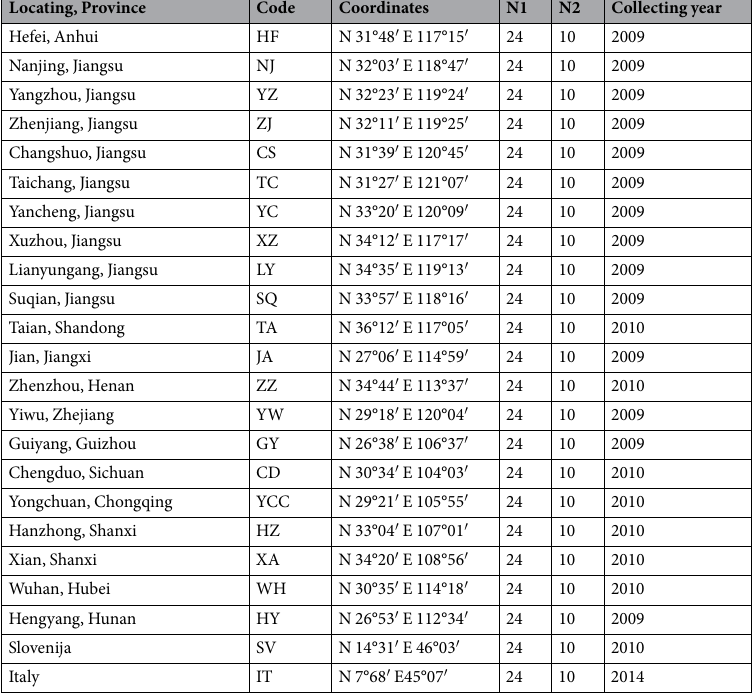
(5 ′ -TAAACTTCAGGGTGACCAAAAAATCA) 44 , ND1-F (5 ′ -ATTCAGACTCTCCTTCAGCA) and ND1-R (5 ′ -GGATAACAGCCTAATCTTCT), and ND5-F (5 ′ -AAAATCACCTCAACTATCAT) and ND5-R (5 ′ -GCTCCTACACCAGTTTCTTC). Primers for ND1 and ND5 were designed based on the complete mito- chondrial genome sequence of C. ciliata 45 . Conditions for PCR amplification were as follows: initial denatura- tion for 5 min at 95 °C, followed by 35 cycles at 94 °C (1 min each), annealing for 1 min at 45–50 °C, elongation for 1–3 min (depending on predicted fragment length) at 68 °C, and a final extension step at 72 °C for 10 min. Amplification products were purified and then sequenced by Invitrogen Biotechnology Co. (Shanghai, China). Amplification of microsatellites and determination of fragment size. The nine microsatellite loci, primer sequences, and PCR conditions used in the current study were previously described by Yang et al. 46 . Amplifications were conducted using DNA from 24 individuals per population (total number = 552). Amplified PCR products were analyzed by Sangon Biotechnology Co. (Shanghai, China) using the ABI 3730 automated DNA sequencer (Applied Biosystems). GENEMAPPER v. 3.5 (Applied Biosystems) was used to obtain allele designations. Fragments comprising the three mitochondrial genes were initially aligned using ClustalX v. 2.0 47 . The number of variable sites and haplotypes, haplotype diversity, and nucleotide diversity of the three mtDNA genes ( COI , ND1 and ND5 ) were calculated by DnaSP v. 5.0 48 . The expected and observed heterozygosity, polymorphic information content, and estimated null frequency were calculated for each locus in individual populations using CERVUS v. 3.0.3 49 . The number of alleles (A), allelic richness (AR), inbreeding index (Fis), and observed and expected heterozy- gosity (Ho and H E ) were calculated by FSTAT v. 2.9.3.2 50 . The deviation from Hardy-Weinberg equilibrium for each population and linkage disequilibrium for pairs of loci was calculated with GENEPOP v. 3.4 51 , and P values were adjusted using the Sequential Bonferroni procedure 52 . Null alleles were identified using Micro-Checker v. 2.2.3 53 . T-tests were used to evaluate the significance of differences in diversity estimates haplotype diversity (H), nucleotide diversity ( π ) and number of alleles (A) of the populations using JMP v.12. Population groups were identified using concatenated sequences of the three mtDNA genes; information on longitude and latitude were included, and the data were analyzed using SAMOVA v. 1.0 54 . The most likely number of clusters (K) was determined by repeating the analysis with K ranging from 2 to 6 and selecting the subdivision scheme associated with the highest F CT . The clustering of individuals from all populations was determined using Structure v. 2.0 55 . The most supported number of clusters (K) was obtained based on multilocus microsatellite data. We used an admixture ancestry model and the correlated allele frequency model with a burn-in period of 100,000 iterations and 1,000,000 Markov chain Monte Carlo (MCMC) repetitions to calculate the most likely number of genetic clusters. We performed 10 independent runs for each K to confirm consistency across runs, tested K from 1 to 8, and used the Δ K method of Evanno et al . 56 to choose the most supported value of K. 13 Scientific RepoRts | 7: 635 | DOI:10.1038/s41598-017-00279-5